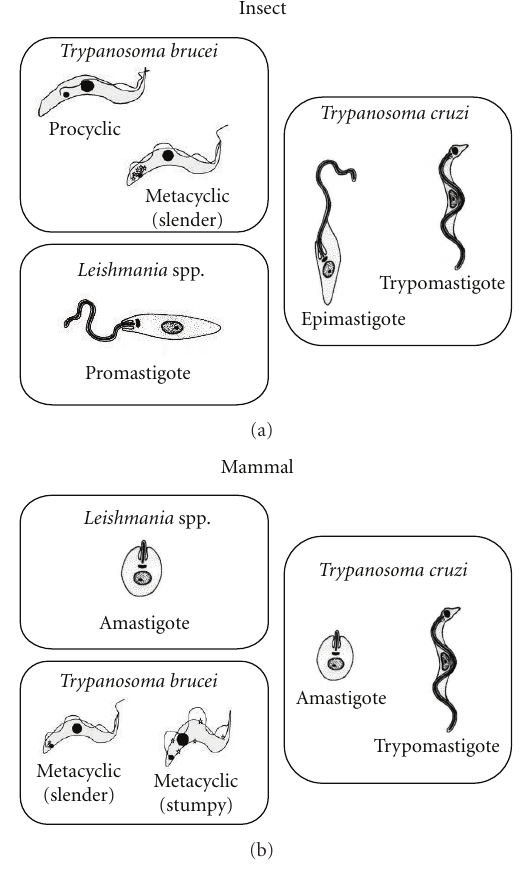
Figure 2: Schematic representation of main morphologies found during the life cycle of some members of the Trypanosomatidae family in the invertebrate host (insect) and vertebrate host (mam-